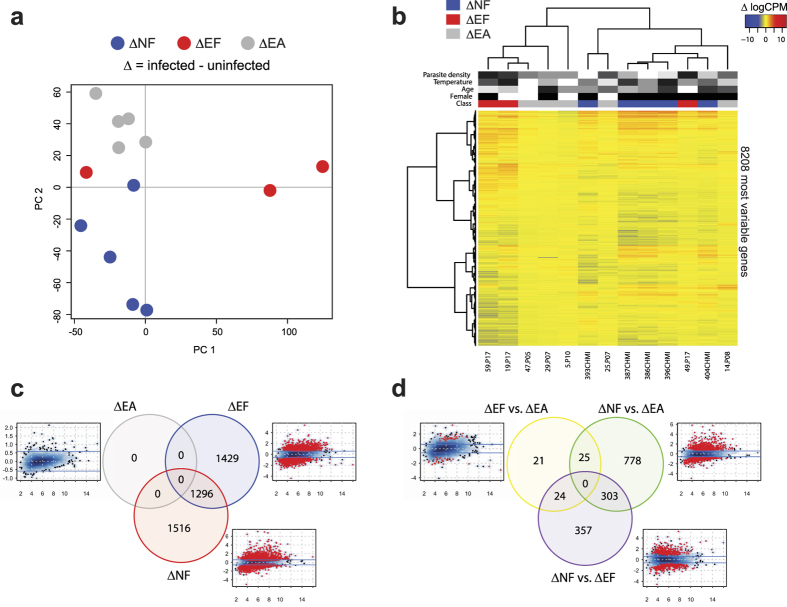
Whole-blood transcriptomic analysis of paired uninfected and infected samples demonstrates greater gene expression changes in NF than EF individuals during febrile malaria.Clinical classes were defined as in Fig. 1, and characteristics of subjects used in this analysis are in Table 1. (a) Principal component analysis of the paired RNA-seq samples (infected – uninfected baseline samples for each subject) using the top 50% most variably expressed genes across all paired samples after normalization of raw data (n = 13 subjects). (b) An unsupervised clustering heat map (Spearman correlation with Ward’s linkage) of the top 50% most variably expressed genes (8208 genes). Red intensity indicates increased expression with infection, and blue intensity indicates decreased expression with infection. Clinical classes are denoted as blue (NF), red (EF), and gray (EA). Female gender is denoted as black. Grayscale intensities represent relative rankings for age, temperature, and parasite density. Differential gene expression analysis for paired infection vs. uninfected baseline comparisons within each clinical class (c) and between each class (d) using contrasts described in the Methods. Venn diagrams show the number of differentially expressed genes (DEGs) using an absolute log2 fold-change (logFC) of >0.585 (1.5-fold in linear space) and a false discovery rate (FDR) <0.05. For the smear density plots, the average expression in log counts per million (x axis) is plotted against logFC (y axis), DEGs with FDR <0.05 are visualized as red points, and the fold-change cut-off is represented as blue lines.